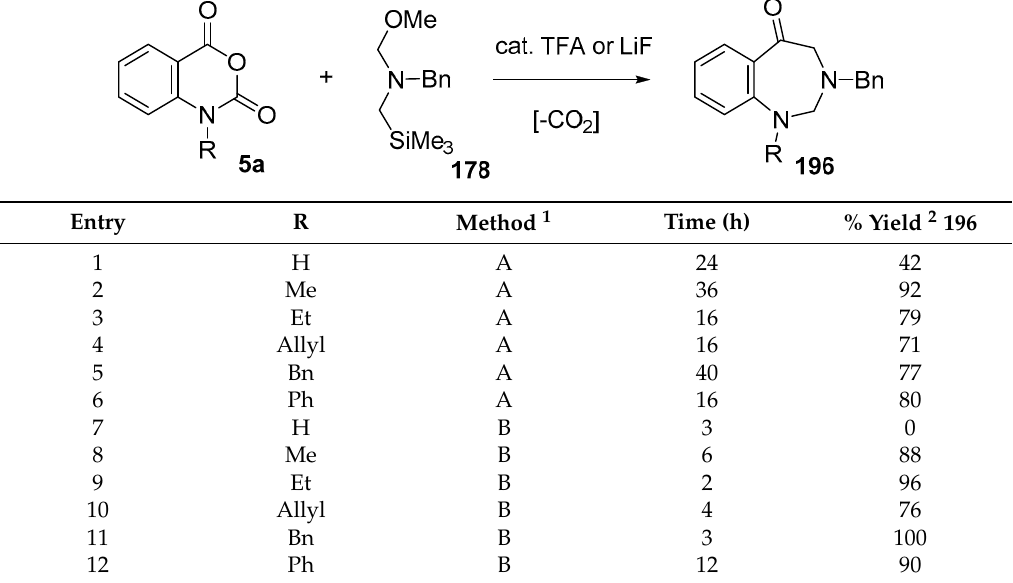
Table 25. Transformation of isatoic anhydride and N -functionalised isatoic anhydrides 5a into 1,3-benzodiazepin-5-ones 196 .